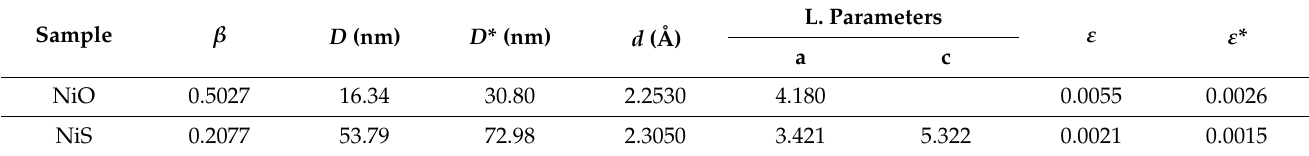
Table 6. Crystallite size and lattice parameters of NiO and